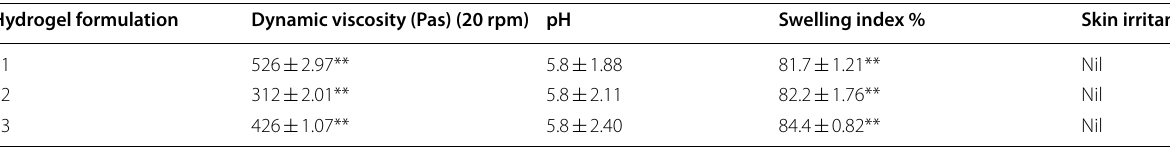
Results are expressed as mean